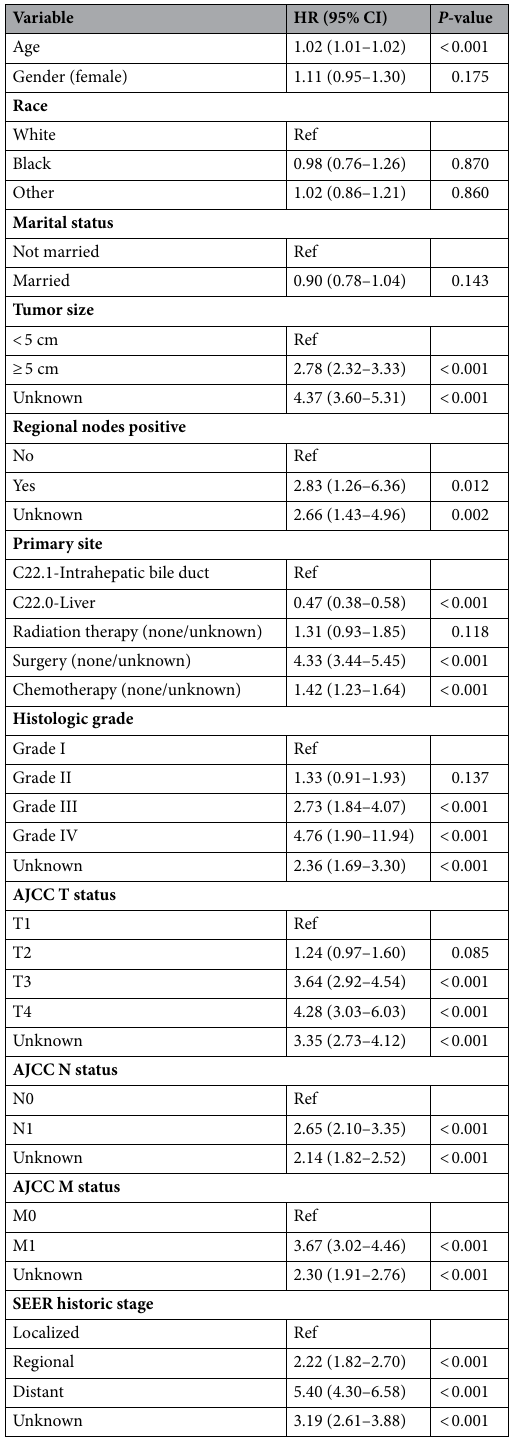
Table 2. Screening for potential confounding factors. HR hazard ratio, CI confidence interval, Ref reference, AJCC American Joint Committee on Cancer, SEER the Surveillance, Epidemiology, and End